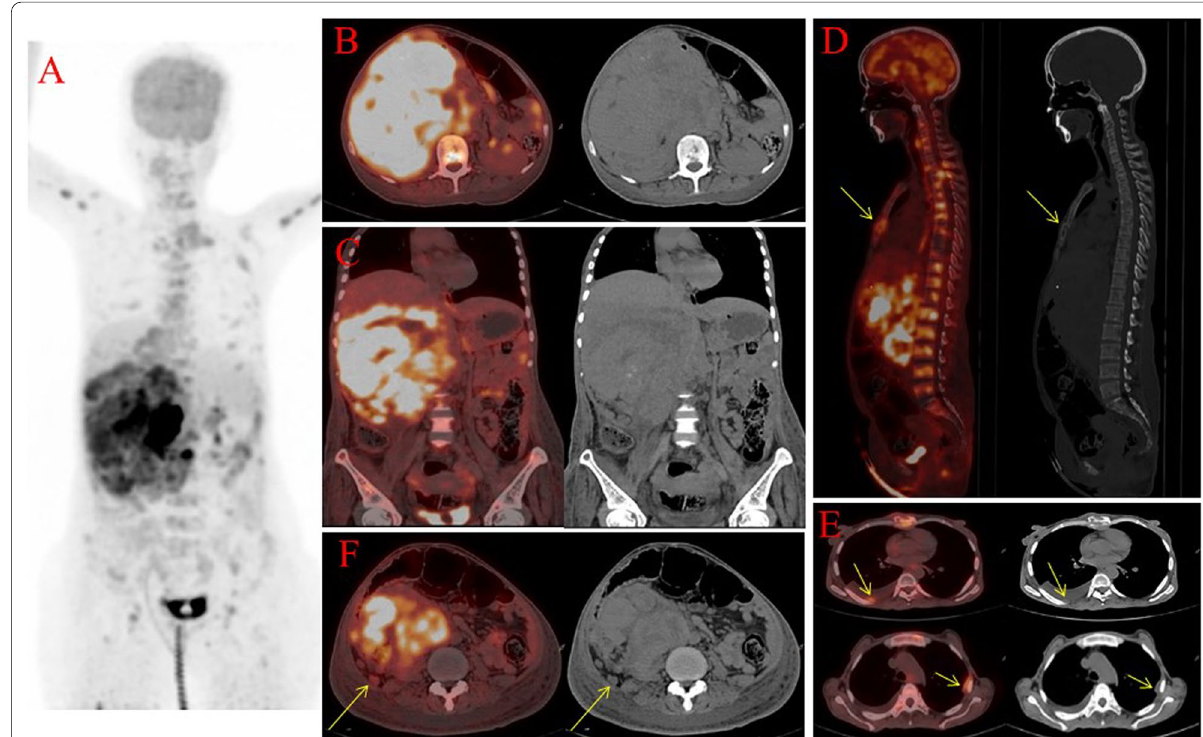
Fig. 2 A represents the maximum intensity projection image of PET/CT scan showing a large area of tracer uptake in the right side of abdomen with focal tracer uptake in bilateral thoracic region and multiple areas in visualized axial and appendicular skeleton. B and C reveal the axial and coronal PET/CT and corresponding CT image showing enlarged right kidney with lobulated large mass with necrotic areas showing increased FDG uptake in the PET. D PET/CT and corresponding CT showing FDG avid lytic lesions in sternum, multiple cervical and dorsolumbar vertebrae. E arrows represent FDG avid bilateral pleural deposits with right pleural effusion. F arrows represent FDG avid retroperitoneal lymph